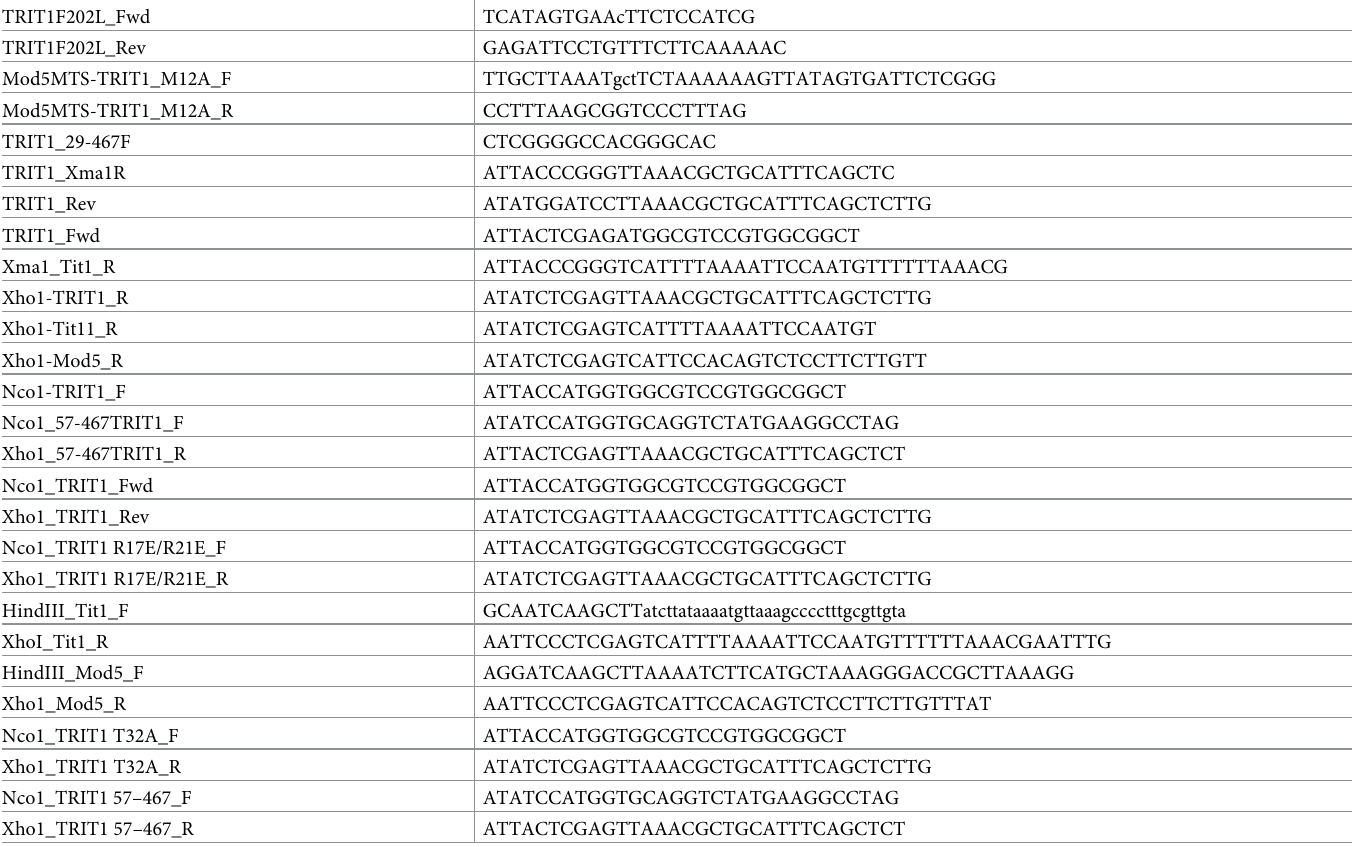
Table 3. PCR Primers used in this